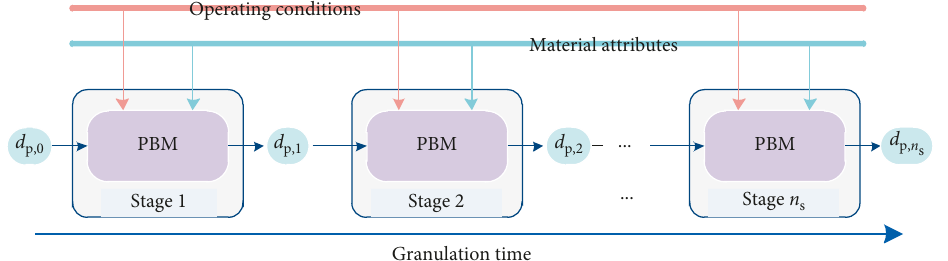
Figure 5: Schematic diagram of the simulation modeling for a segmented